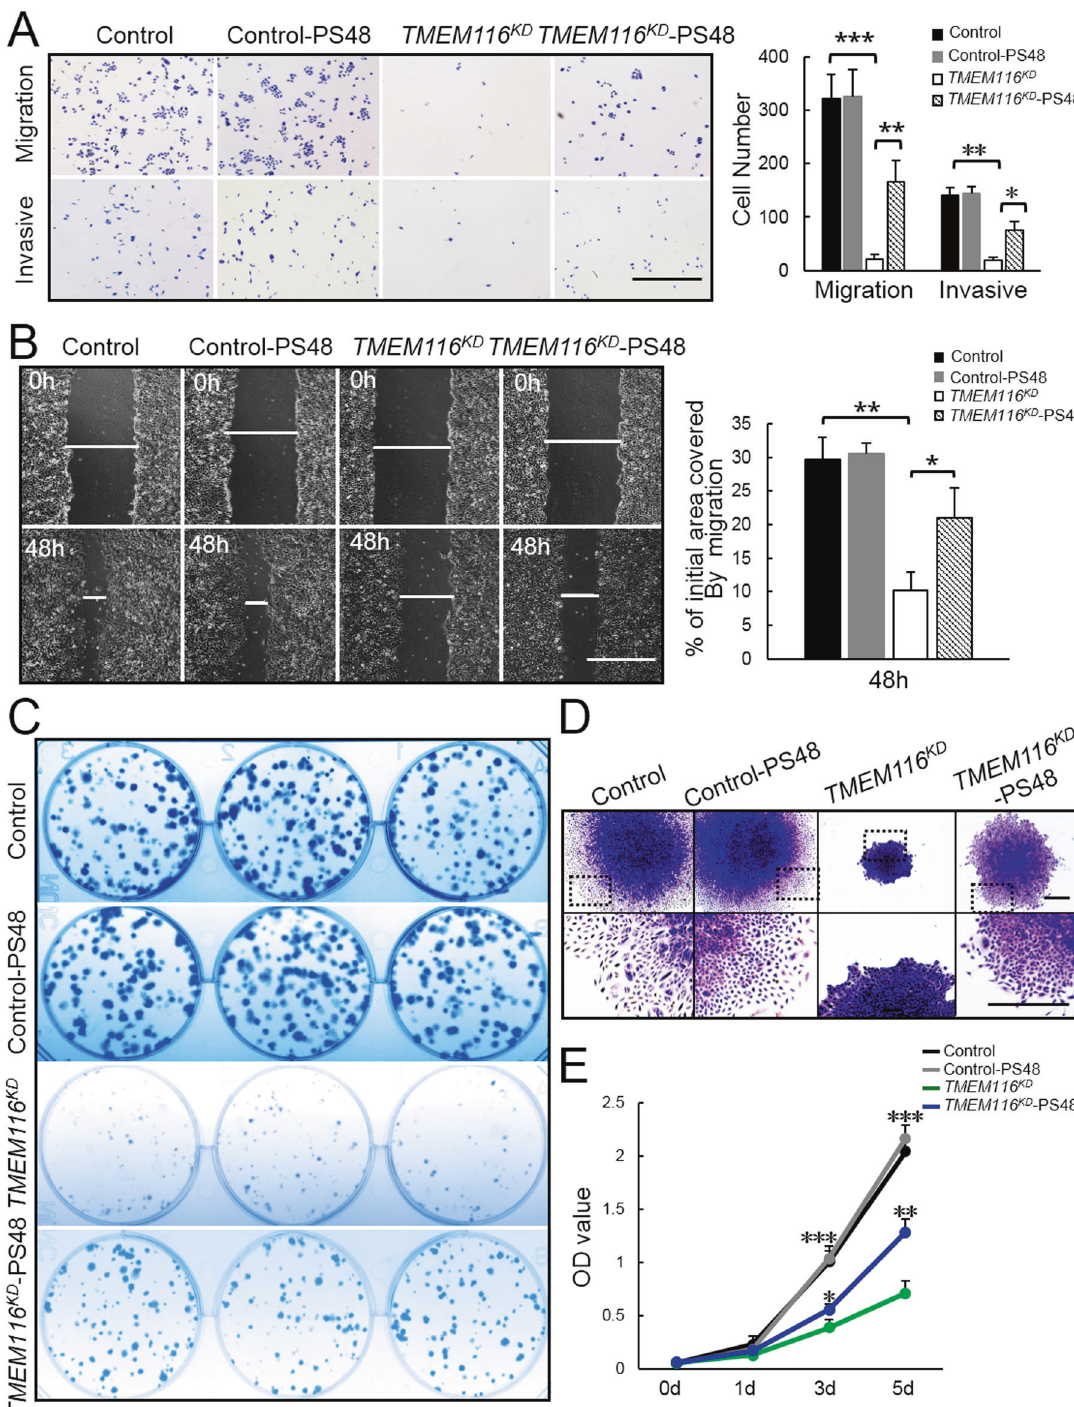
Fig. 6 Activation of PDK1 largely restores the proliferation, clone formation, migration and invasion of TMEM116 KD cells. A Control, control-PS48, TMEM116 KD and TMEM116 KD -PS48 cells were subjected to Transwell migration and invasion assays. More than three fi elds of cells in the lower chambers were counted. Scale bar: 1000 μ m. B Control, control-PS48, TMEM116 KD and TMEM116 KD -PS48 cells were subjected to wound-healing assay. Scale bar: 1000 μ m. Representative images from over 30 non-overlapping fi elds at each time point are shown. C Control, control-PS48, TMEM116 KD and TMEM116 KD -PS48 cells were subjected to colony formation assay. D Control, control-PS48, TMEM116 KD and TMEM116 KD -PS48 cells were subjected to colony morphology analyses. Scale bar: 500 μ m. E Control, control-PS48, TMEM116 KD and TMEM116 KD - PS48 cells were subjected to CCK8 assays at 0, 1, 3, 5 days. The bars represent the mean ± SD. * P < 0.05, ** P < 0.01, *** P < 0.001. n = 6 mice. Representative images from three independent experiments are shown above.